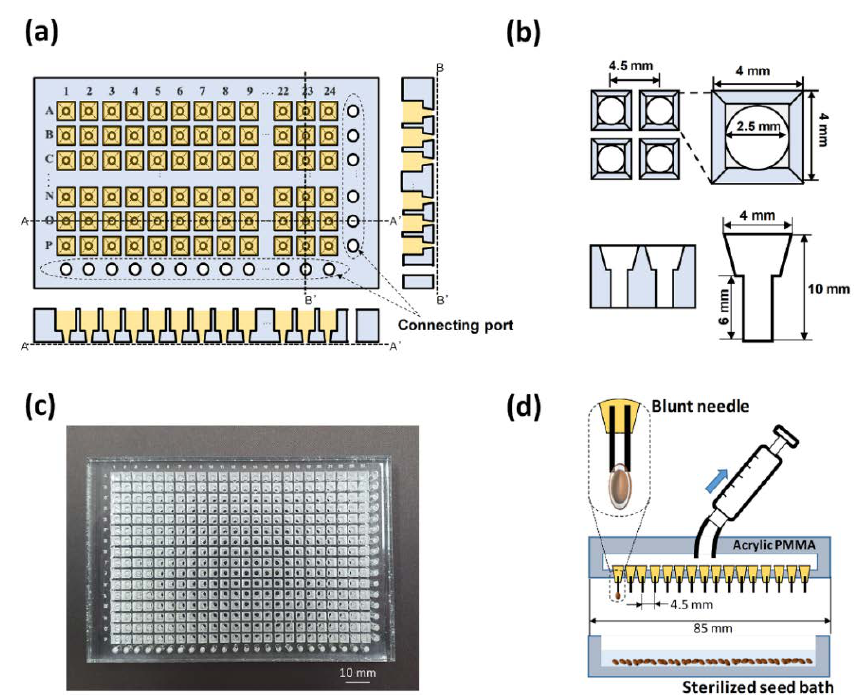
Figure 1. Configuration of a 384-well type plant array chip that was fabricated by laser machining with an acrylic poly(methyl methacrylate) (PMMA) plate. ( a ) Schematic top and side views of a 384-well type plant array chip. ( b ) The dimensions of each well that was fabricated in a 384-well type plant array chip. ( c ) Photograph of the fabricated plant array chip compatible with a conventional well plate (127 × 85 × 10 mm). ( d ) A home-made micro-vacuum seeder for a high efficiency of seeding on a 384-well type plant array chip. There were 16 needles in the seeder head.